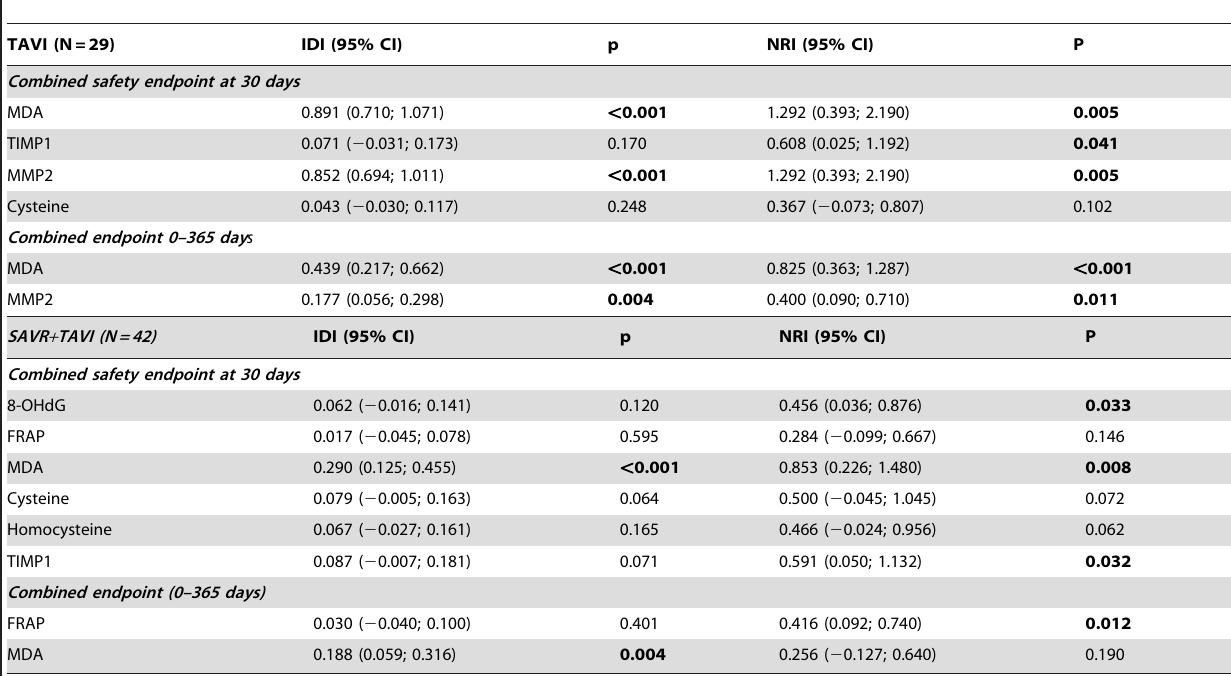
Table 7. Evaluation of additional benefit of biomarkers to clinical model (EuroSCORE) by net reclassification improvement (NRI) and the integrated discrimination improvement (IDI) for prediction of combined safety endpoint at 30 days and combined endpoint (0–365 days) in groups of patients treated by TAVI and by SAVR and